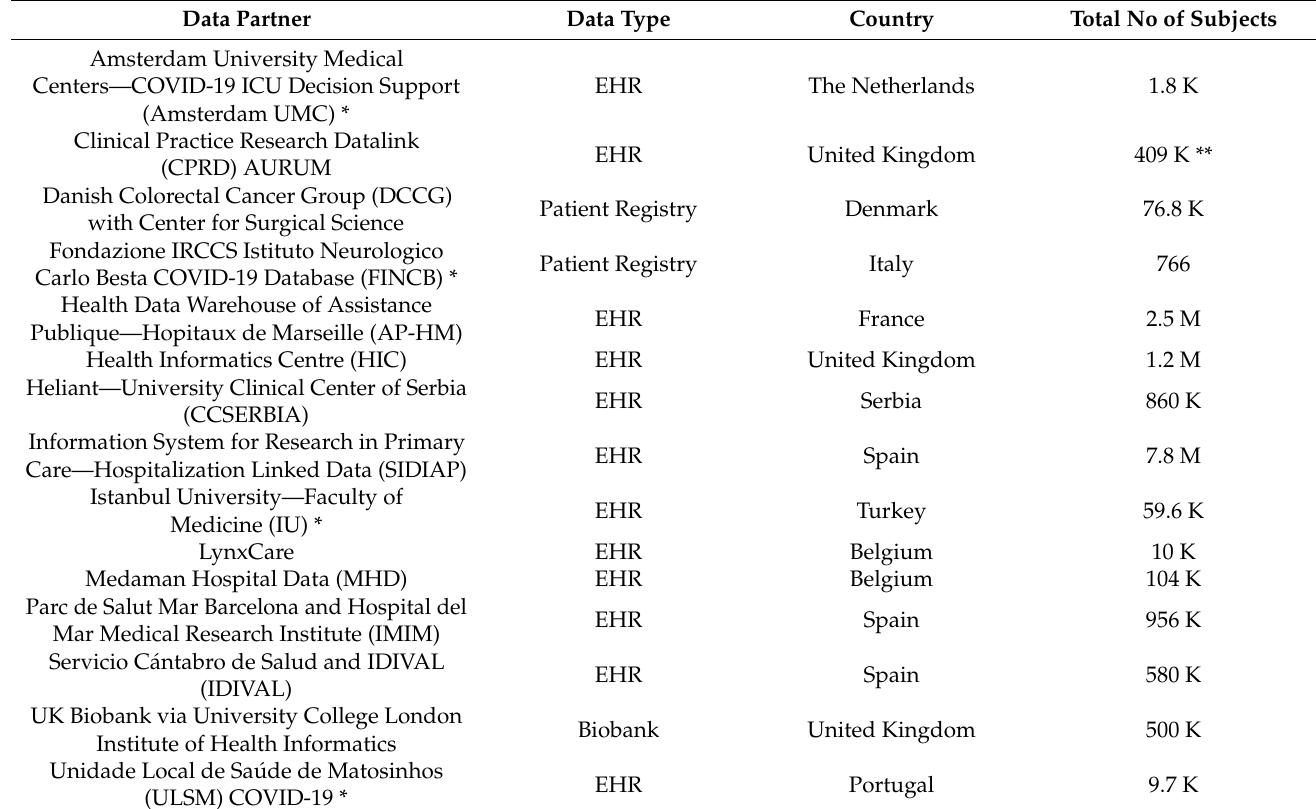
Table 1. Data Partners (DPs) that contributed data (alphabetical